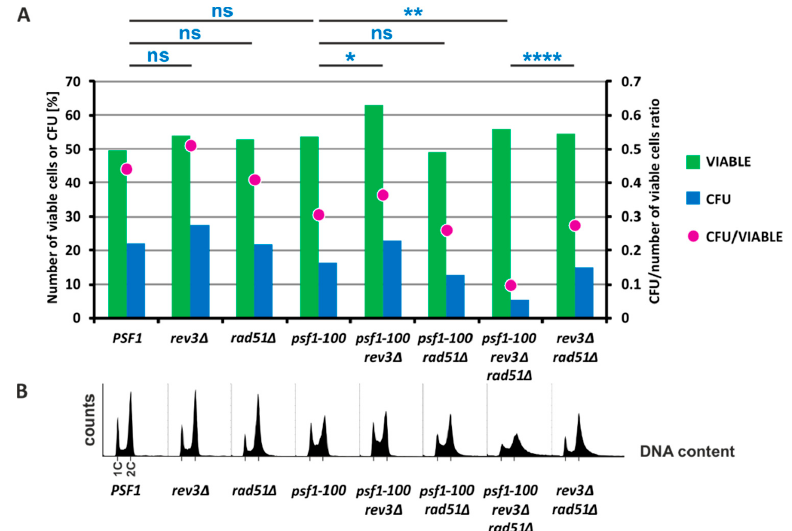
Figure 4. The Pol ζ -dependent error-prone pathway and the homologous recombination-dependent error-free pathway are necessary for the survival of psf1-100 cells. ( A ) The number of viable cells (green bars) was estimated in stationary phase cultures of the indicated strains by counting propidium iodide (PI)-stained dead cells. In parallel, the number of colonies formed after plating was calculated and compared with the total number of cells (blue bars). A statistical T-test was used to determine the p -value ≤ 0.0001 (****); ≤ 0.01 (**); ≤ 0.05 (*). The statistical analysis is shown in Table S6. The proportion of colonies formed from living (PI-negative) cells is shown as purple dots. ( B ) DNA content in asynchronous cells was determined using flow cytometry with SYTOX Green staining. The 1C and 2C DNA content is indicated.